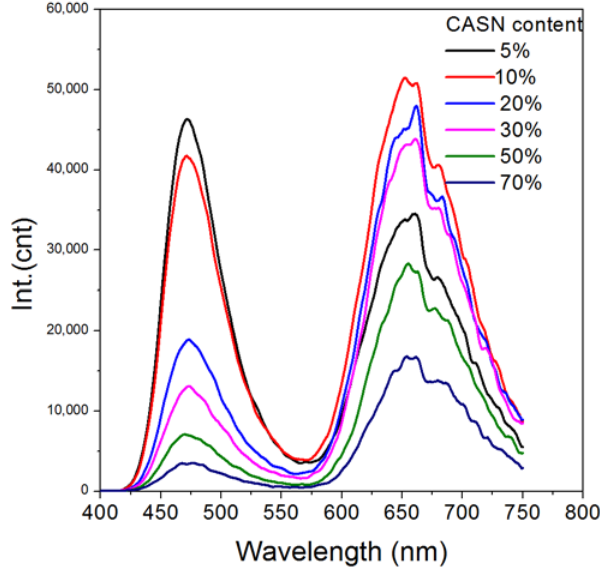
Figure 5. Afterglow emission spectra of CASN/SMS nanocomposite films with diverse CASN content. Samples are excited by using a violet LED torch (395 nm, 9 w).